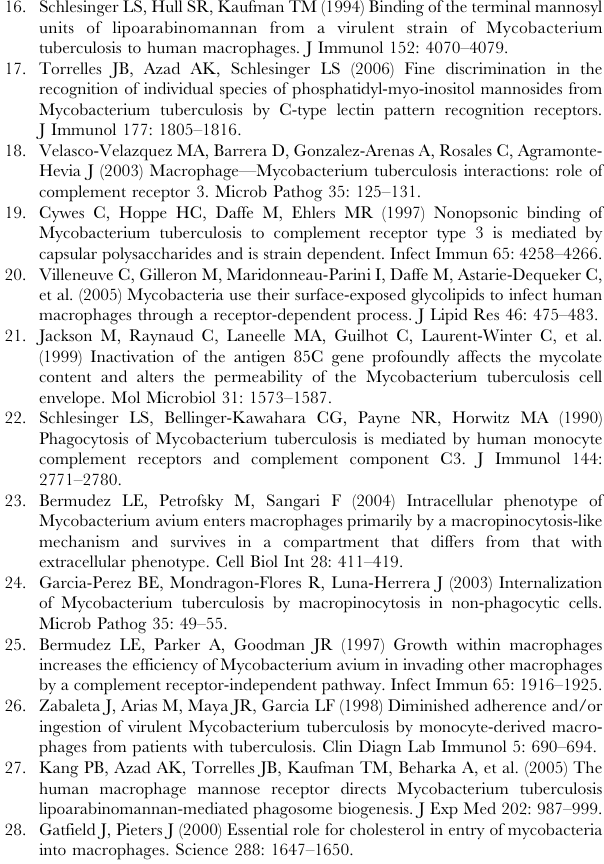
Figure S2 DIM deficiency did not affect the ability of M. tuberculosis to replicate in human macrophages. MDMs were infected for 60 minutes with H37Rv WT (diamonds) or the PMM56 mutant (squares) at MOI 10, washed, and further incubated in the presence of serum. At various times after infection, MDMs were fixed and processed for differentiating intracellular and extracellular bacteria. Intracellular bacilli per macrophage were then quantified by counting 100 macrophages from at least 10 different fields. Values represented the mean +- SEM of three independent